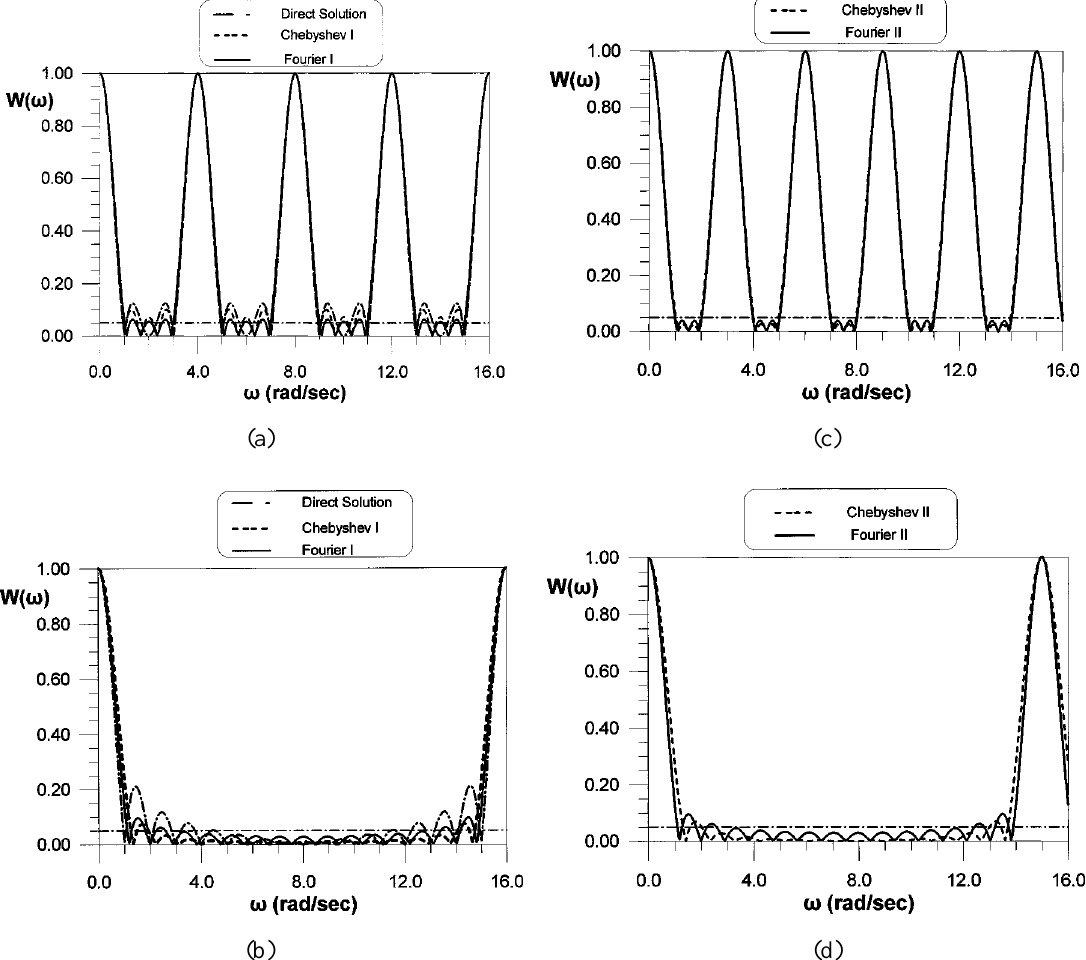
Fig. 4. Error functions of the proposed methods for T p = 2 (cid:25) . (a) N = 4 (Case I), (b) N = 16 (Case I), (c) N = 3 (Case II), (d) N = 15 (Case